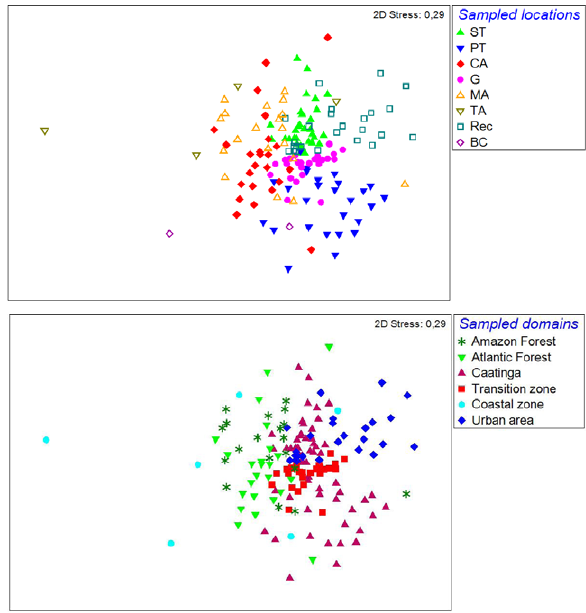
Figure 2. Multi-dimensional scaling plots of the genetic similarities (simple matching index) among the Tropidurus hispidus popula- tions sampled in the present study. See Table 1 and text for acro- nyms. The graphs a/b show the different domains and localities